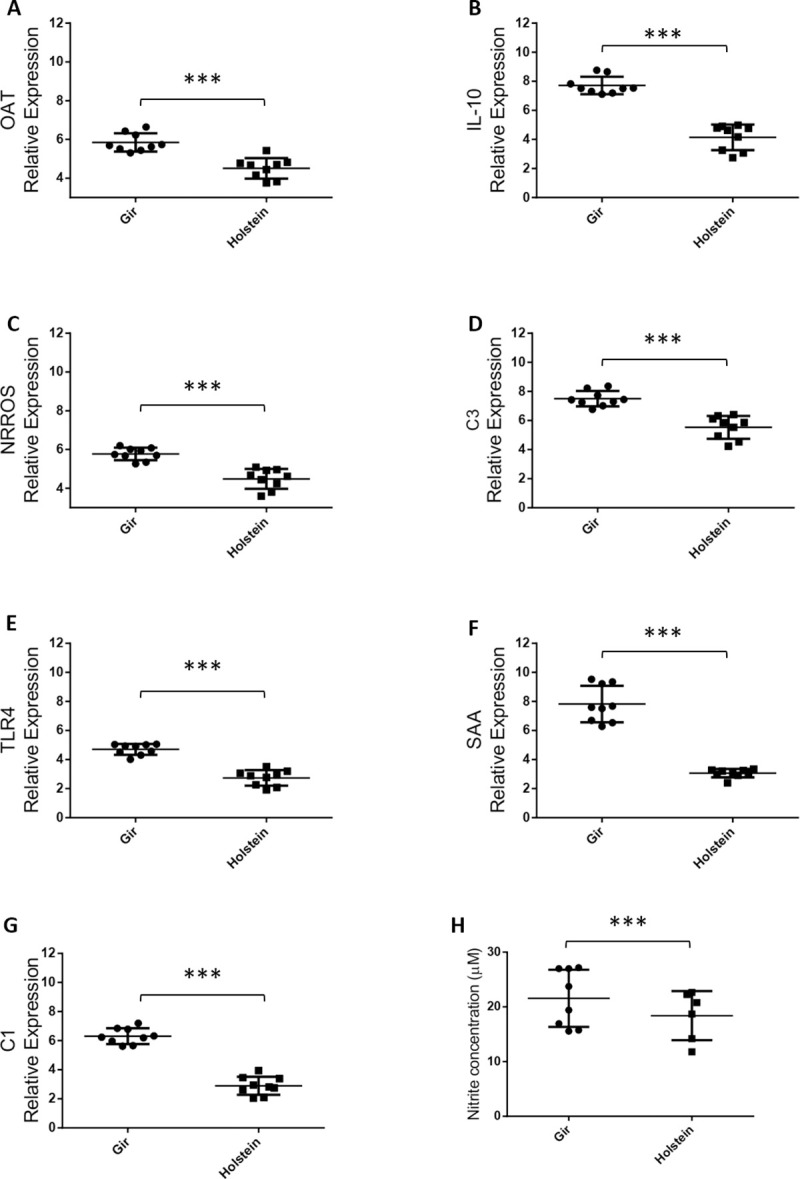
Differential systemic inflammatory responses in Holstein and Gir cattle.(A-G) Gene expression of inflammatory molecules from Holstein and Gir buffy coat cells by RT-qPCR. All data were shown as target genes ΔCt average ± SD. *** P<0.001, T-test. (H) Nitrite concentration in serum from Holstein and Gir breeds in homeostatic conditions free of pathogens and drug treatment for three months. Data are shown as concentration average ± SD for each group. T-test was used for comparisons between breeds (*P<0.05).